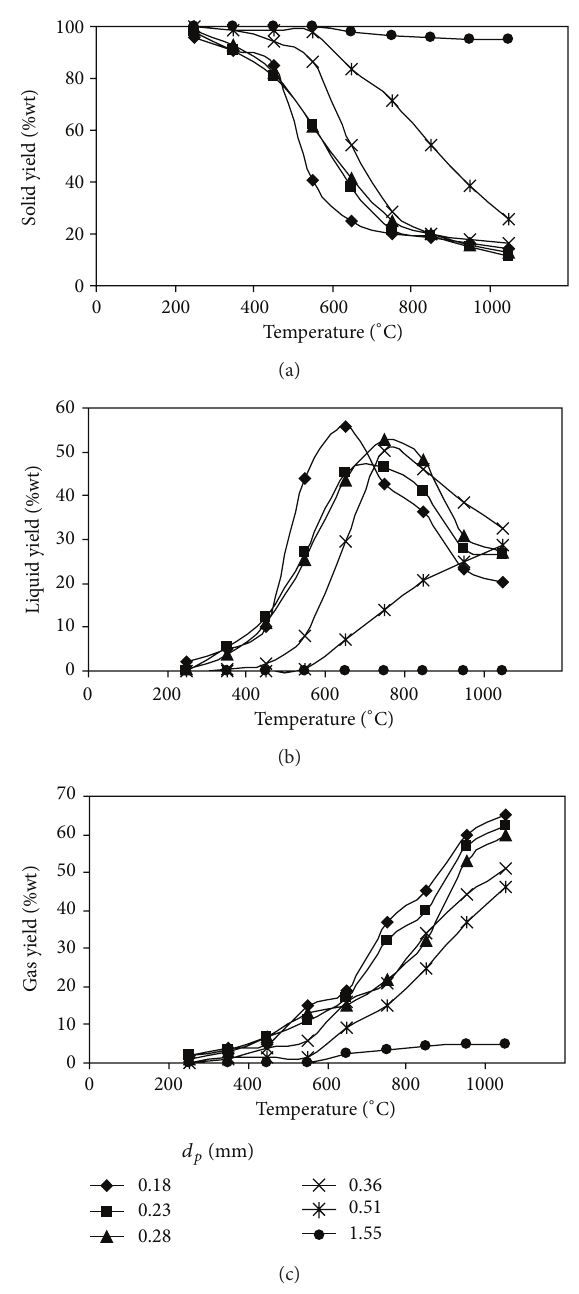
Figure 4: Effect of particle size and pyrolysis temperature on (a) solid yield, (b) liquid yield, and (c) gas yield (palm shell feed rate 0.6 g/min and sweep gas flow rate 200 cm 3